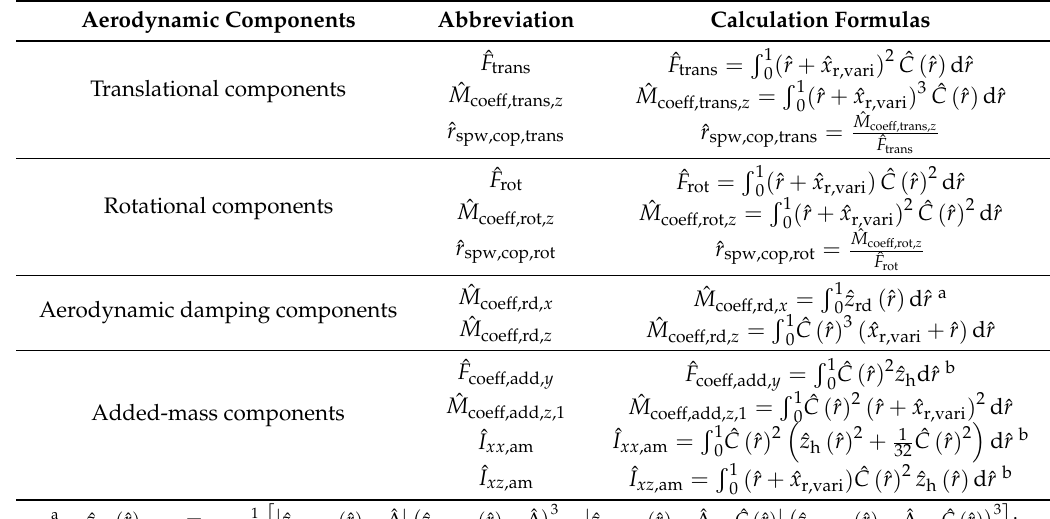
Table 2. Non-dimensional aerodynamic parameters for different aerodynamic